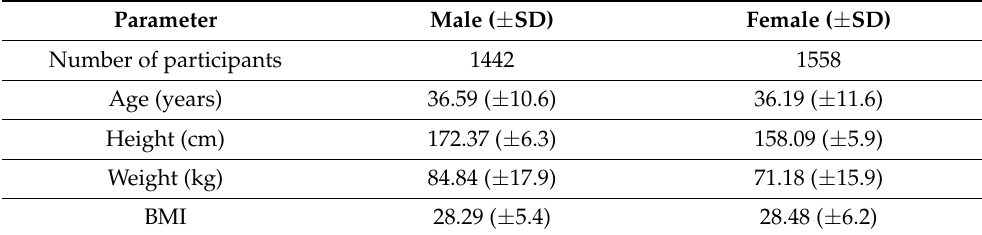
Table 1. The demographics of the study cohort.